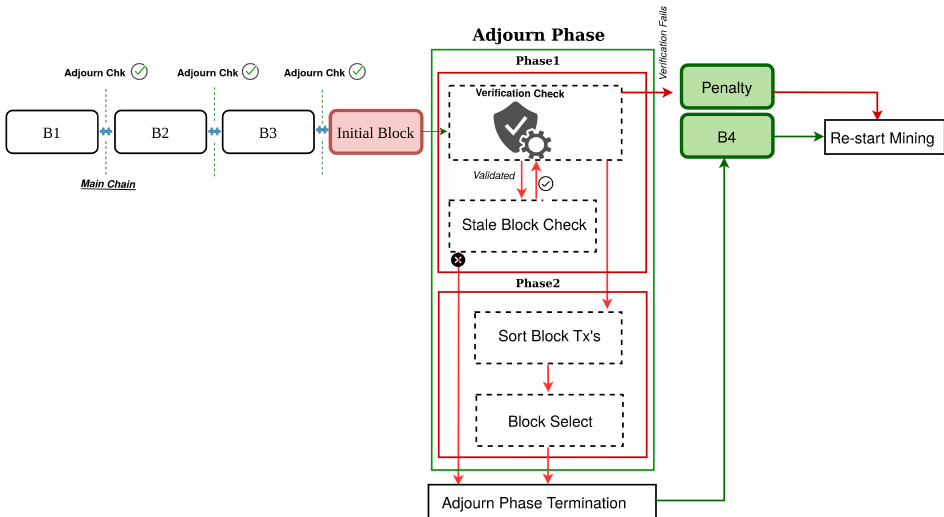
Figure 5. Proof of Adjourn (PoAj)